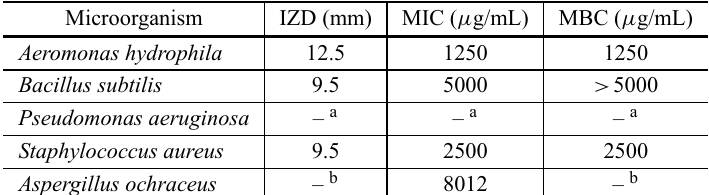
Inhibition zone diameter (IZD), minimal inhibitory concentration (MIC) and minimal bactericidal concentration (MBC) for the crude methanol extract of Solanum palinacanthum aerial part.